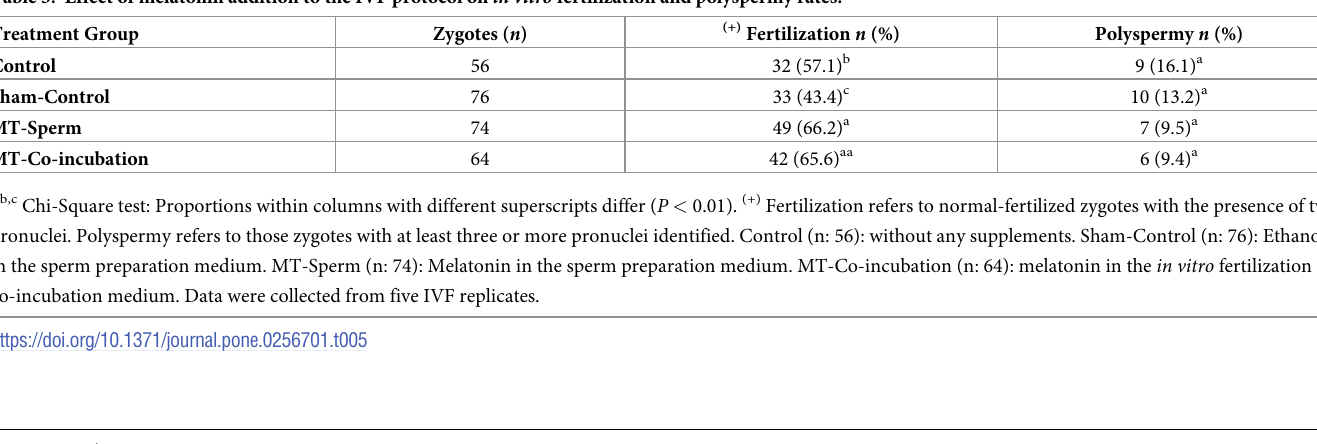
( P > 0.05) effects of treatment or incubation time on the evaluated parameters ( Table 4 ) and the interaction between treatment and incubation time ( S5 Table ).